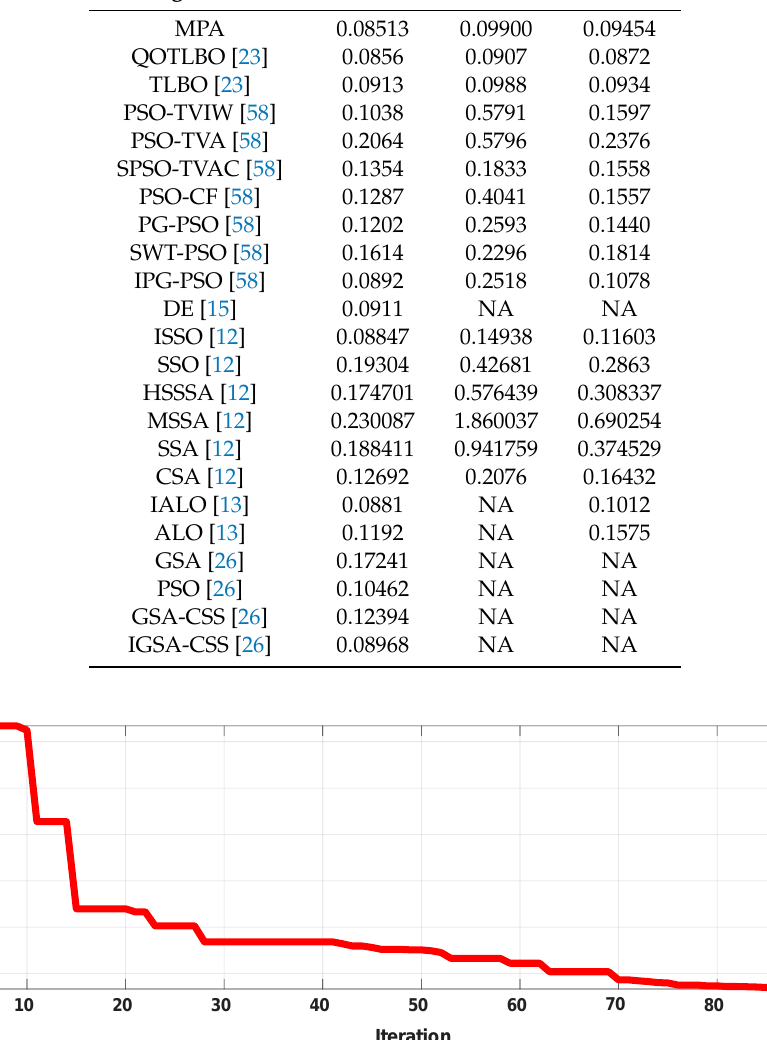
Figure 3. Trends of the power loss by marine predators algorithm (MPA).